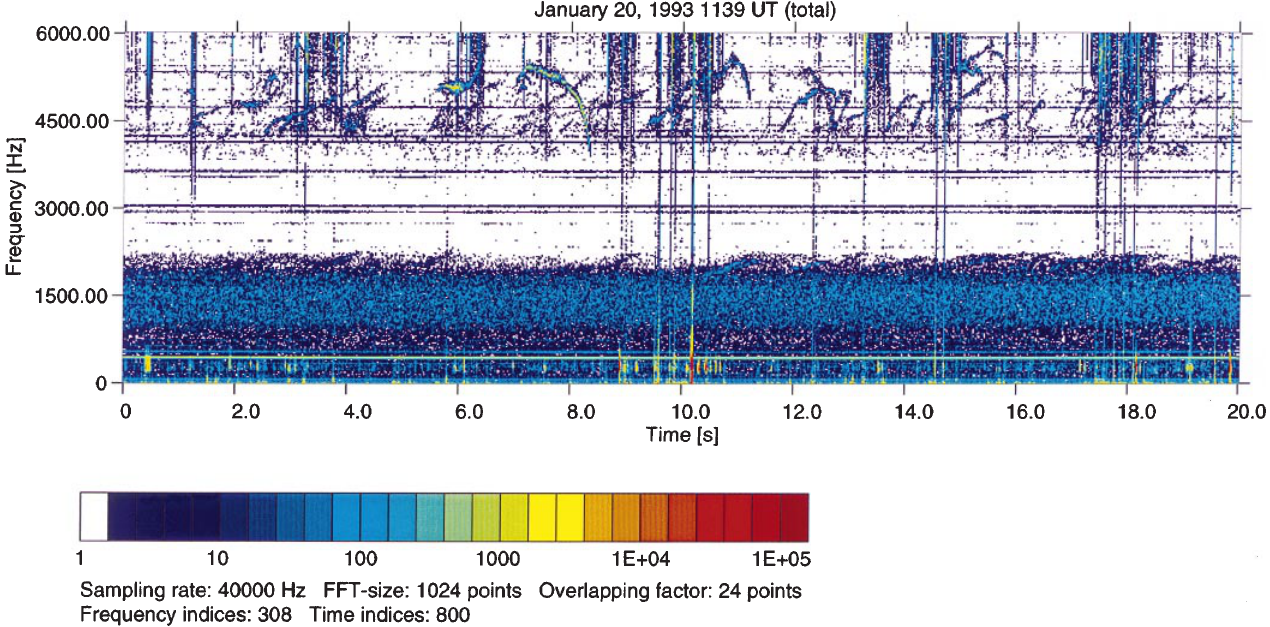
Fig. 4. A variety of discrete PLHR triggered emissions in the band 4–6 kHz. Risers predominate, but there are a number of fallers and downward